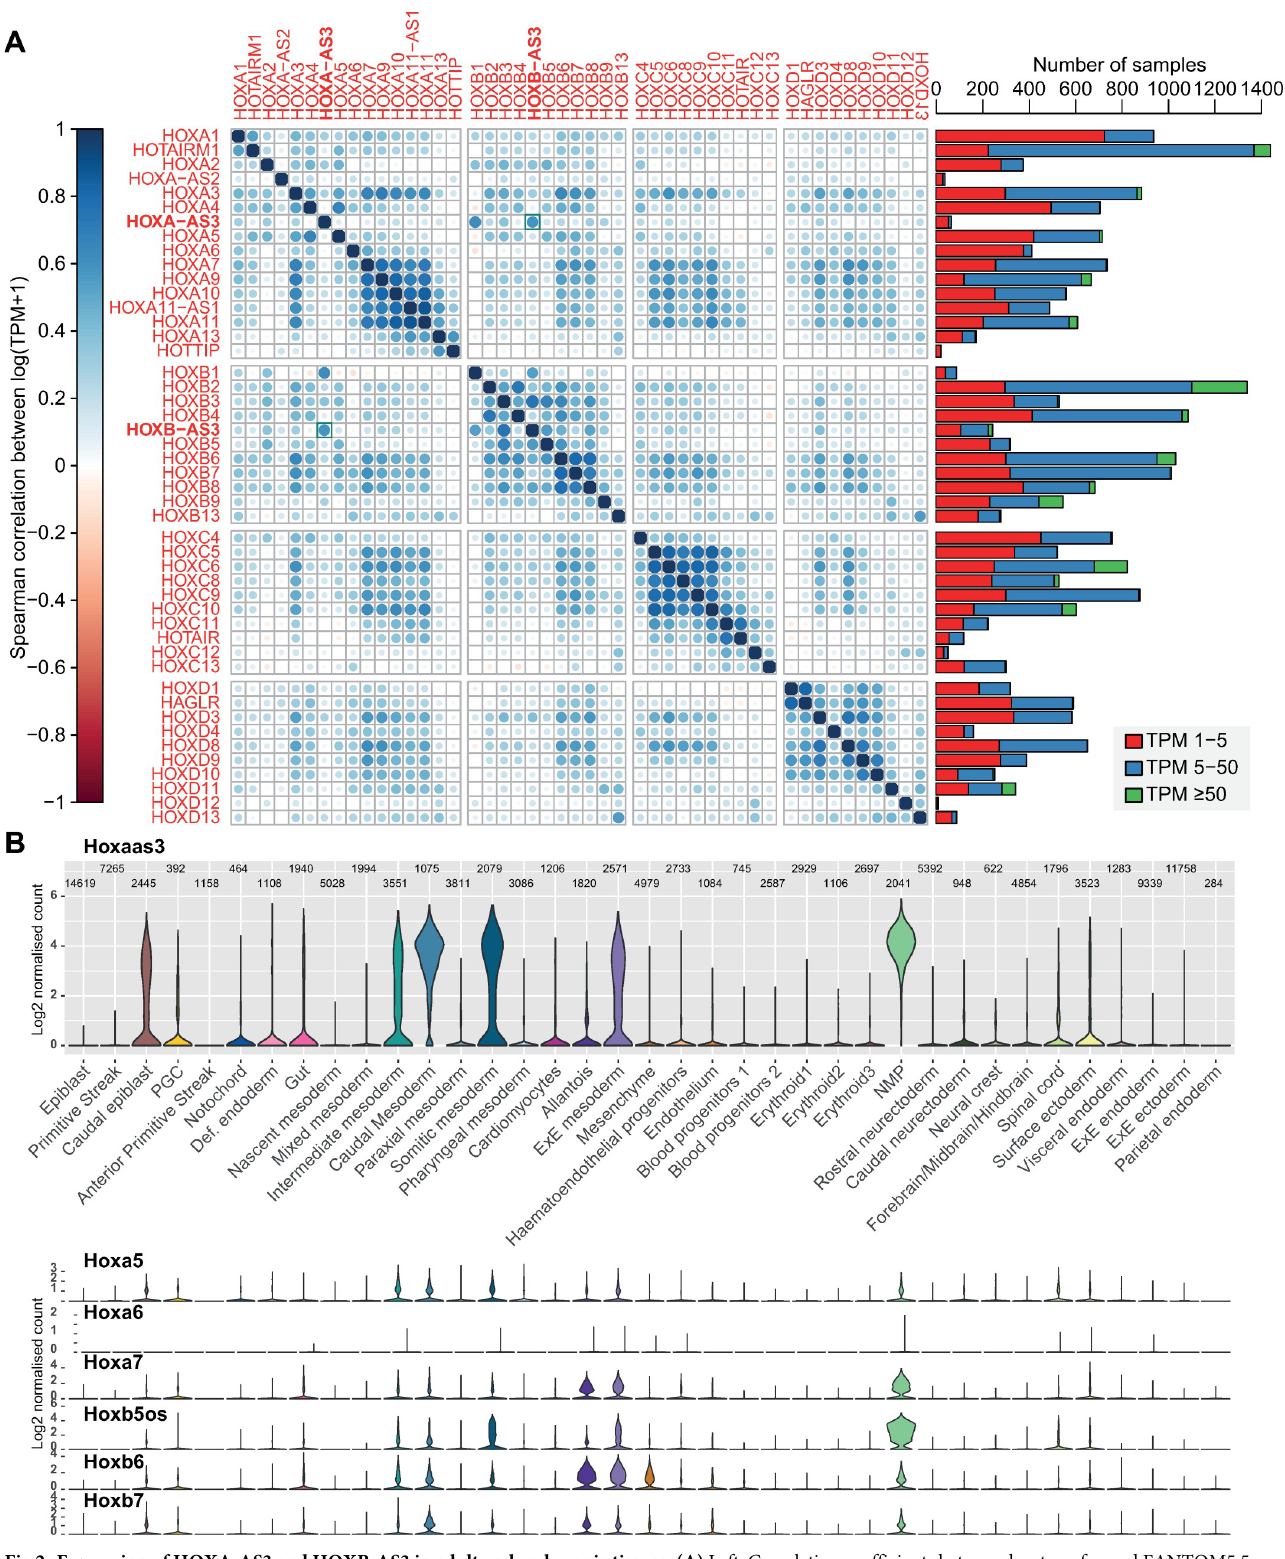
Fig 2. Expression of HOXA-AS3 and HOXB-AS3 in adult and embryonic tissues. (A) Left: Correlation coefficients between log-transformed FANTOM5.5 expression levels [19] in hundreds of samples for the indicated genes. Right: Number of samples in which each gene is expressed within the indicated TPM ranges. (B) Expression levels of the indicated genes in clusters of single cells during gastrulation, data from [25].